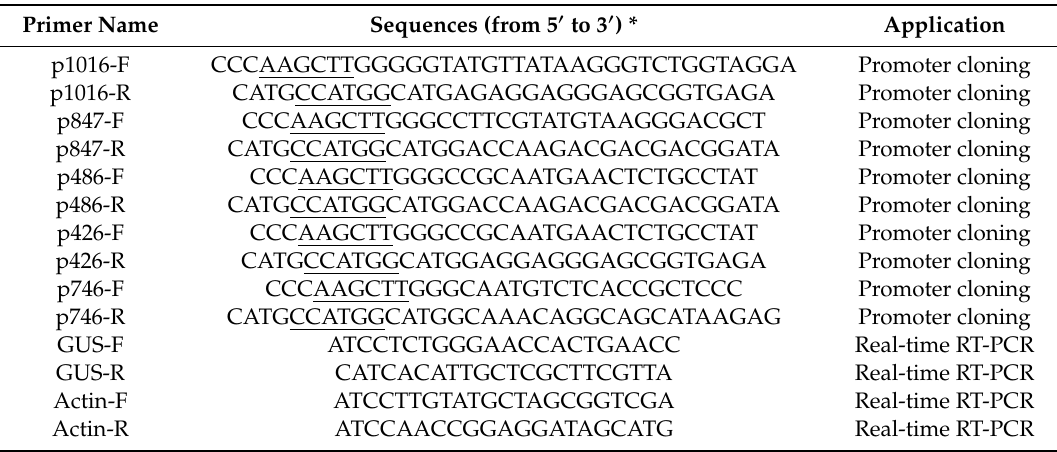
Table 1. Primer sequences used in this study.